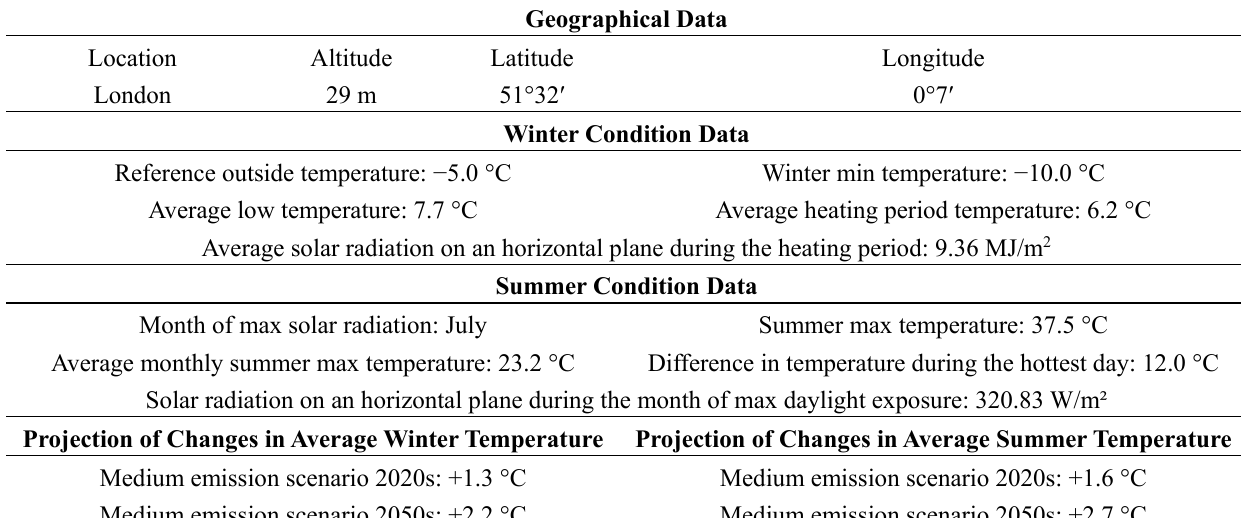
Table 1. Geographical data and boundaries conditions